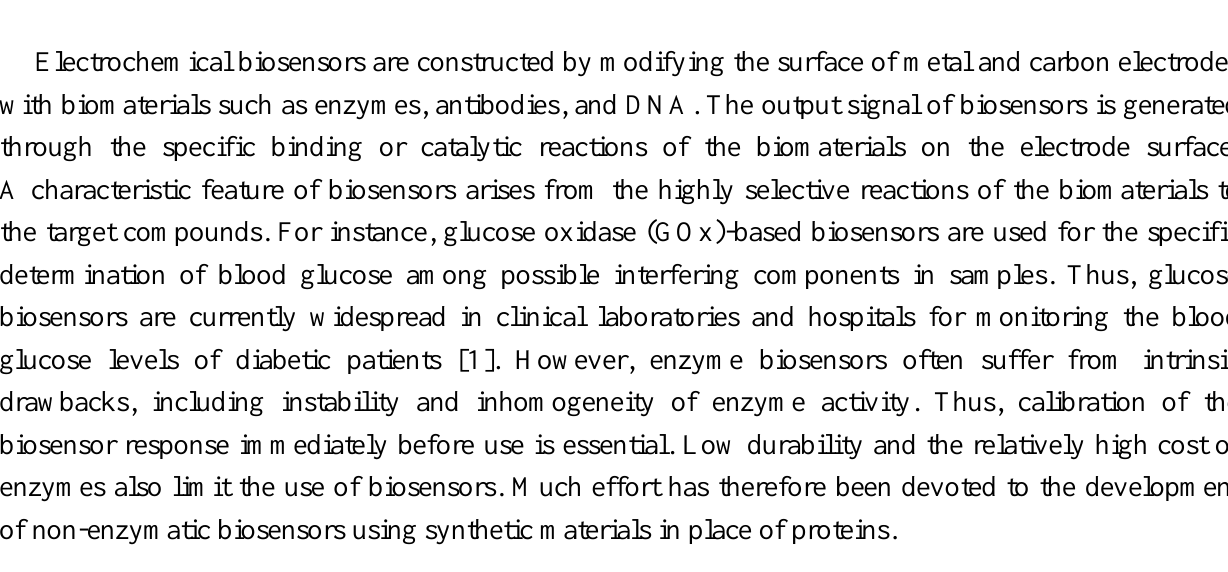
Figure 1. Binding equilibria of phenylboronic acid to sugar and OH −